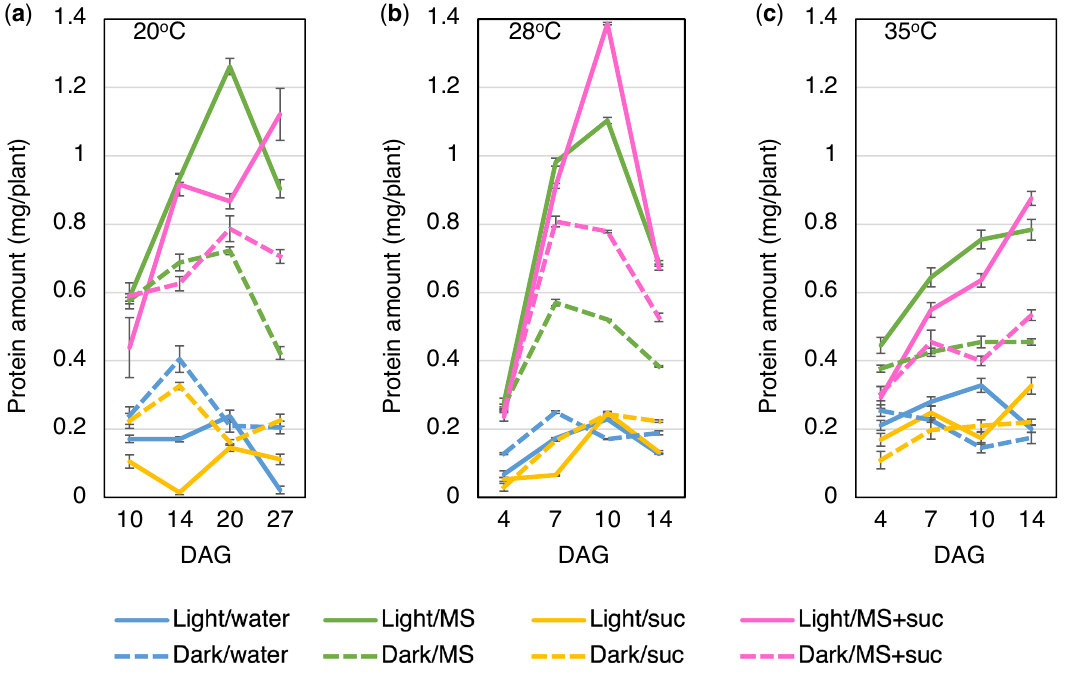
Figure 5. Protein production in rice seedlings grown at different temperatures. Graphs show the total amount of soluble protein extracted from each seedling (n = 5) grown at 20 °C ( A ), 28 °C ( B ), and 35 °C ( C ), and supplemented with MS medium and/or 30 g/l sucrose. DAG: day after